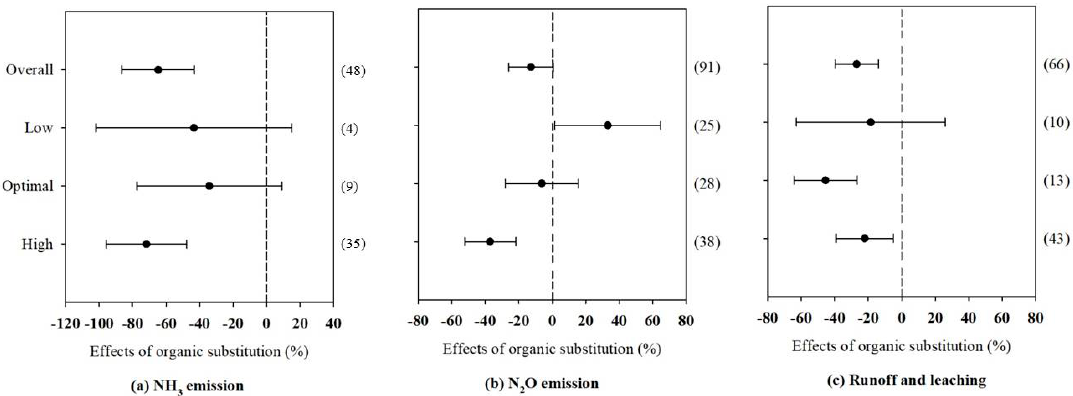
Figure 2. Effects of organic fertilizer substitution on NH 3 emissions ( a ), N 2 O emissions ( b ), and runoff and leaching ( c ) under three fertilization rates (see main text for definitions of low, optimal, and high fertilization rates). Error bars represent 95% confidence intervals. Numbers in parentheses indicate the numbers of observations.